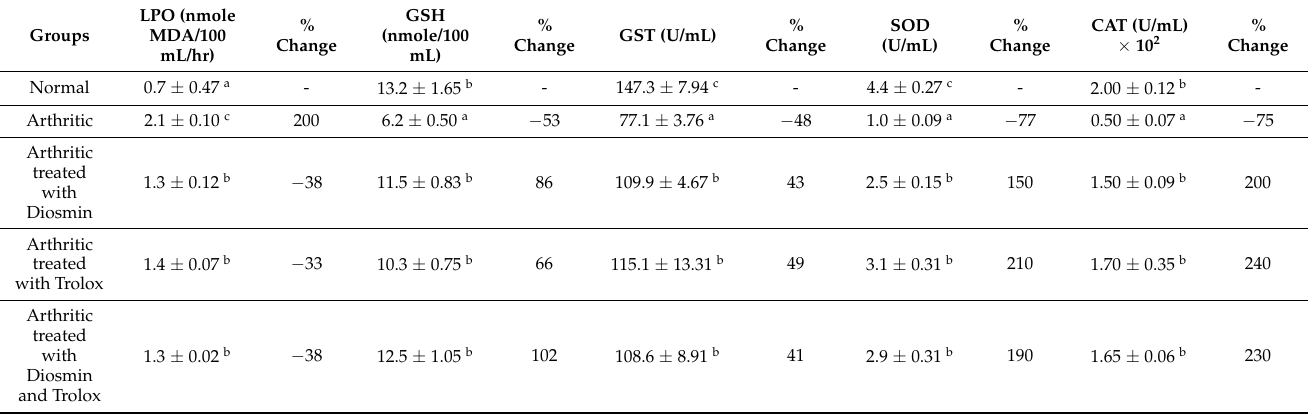
Table 3. Effect of diosmin and/ or trolox on antioxidant defense and oxidative stress markers in the serum of CFA-induced arthritic animals.